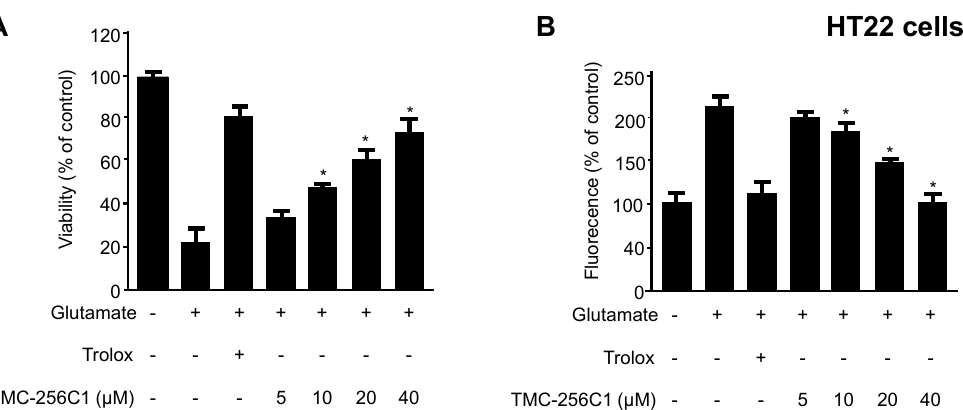
Figure 2. Effects of TMC-256C1 on glutamate-induced oxidative neurotoxicity ( A ); and generation of reactive oxygen species ( B ). HT22 cells were treated with TMC-256C1 and then incubated for 12 h with glutamate (5 mM) ( A ). Exposure of HT22 cells to glutamate resulted in increased reactive oxygen species production ( B ). Data are presented as the mean value of three experiments ± SD. * p < 0.05 compared to the group treated with glutamate. Trolox ® (50 µ M) was used as a positive